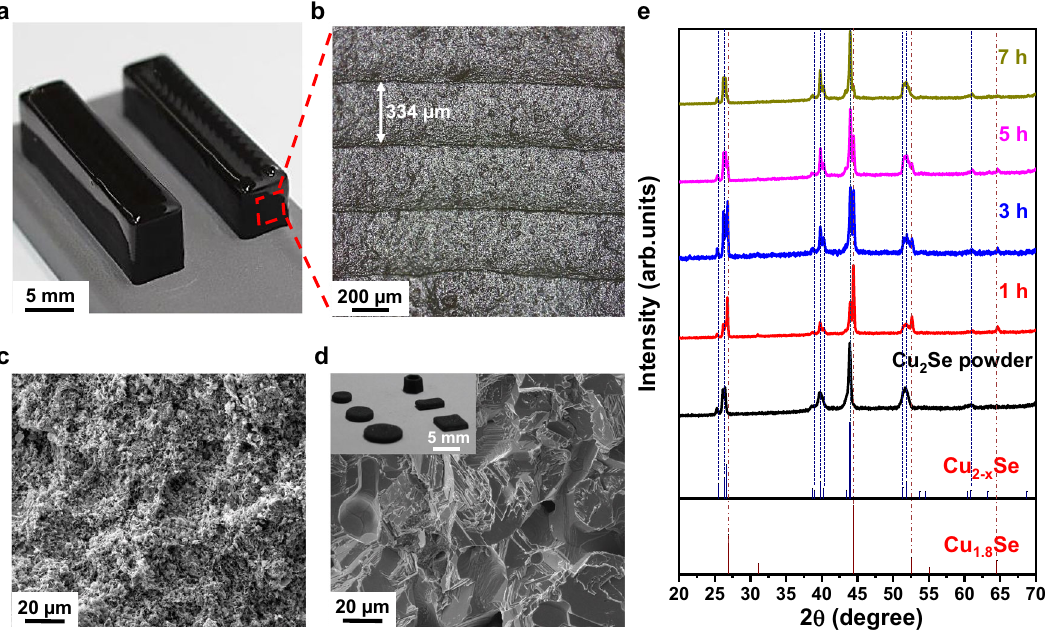
Fig. 3 3D printing of Cu 2 Se TE materials. a Photograph and b OM image of the 3D-printed Cu 2 − x Se cuboids. c , d SEM images of fractured surfaces of the 3D-printed Cu 2 − x Se ( c ) before and ( d ) after sintering at 873 K for 5 h. The inset of the panel ( d ) shows the photograph of 3D-printed and sintered Cu 2 Se TE materials with various samples. e XRD patterns of as-synthesized Cu 2 Se powder and sintered samples for 1, 3, 5, and 7 h for 873